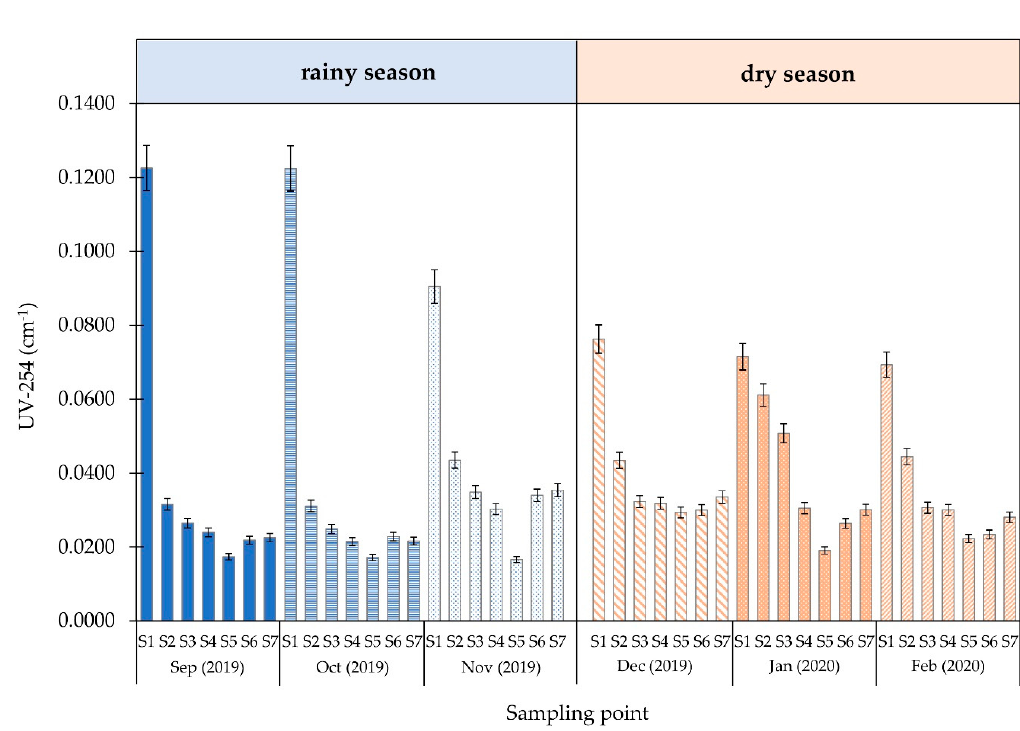
Figure 5. UV absorbance (UV-254) of water at each sampling